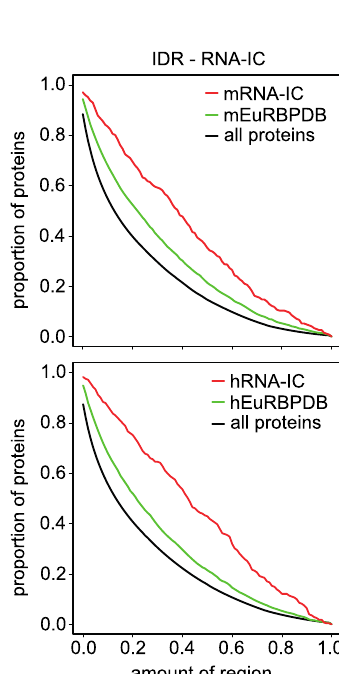
orchestrate redundant, cooperative, and antagonistic effects into a coordinated higher-order regulation. effector cells (Teff) expanded under T H 0 culture conditions, which